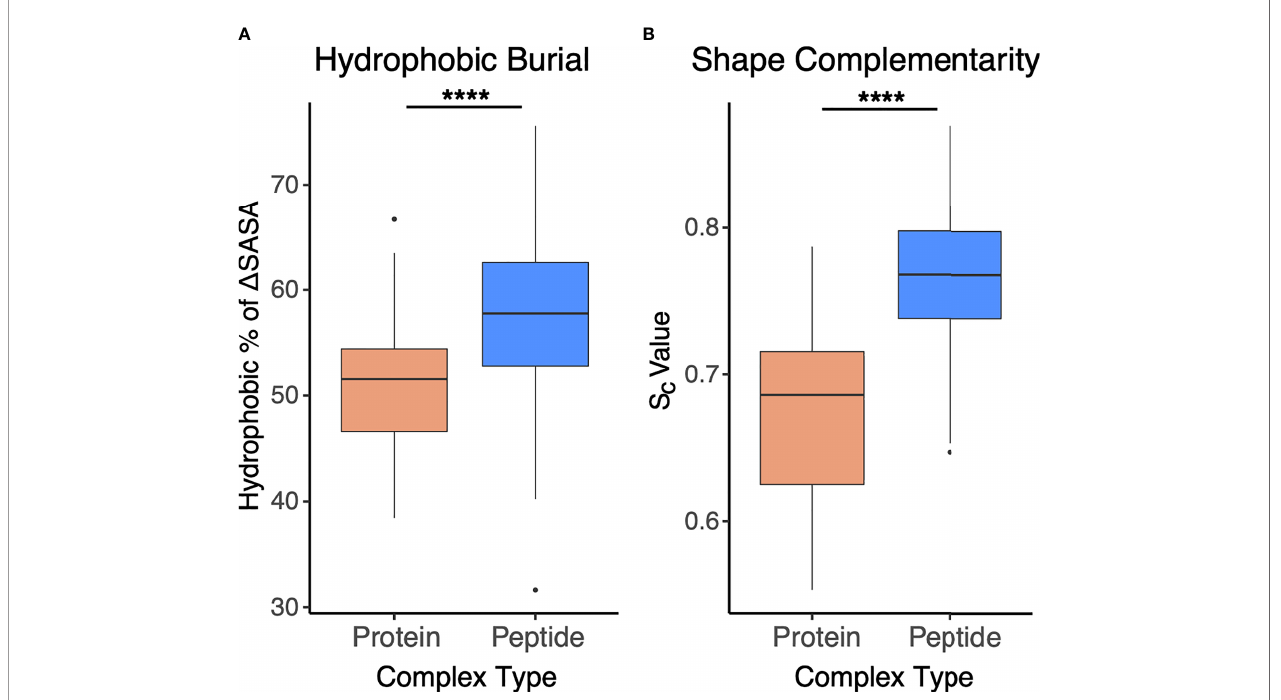
FIGURE 6 | Interface hydrophobicity and shape complementarity of antibody-peptide versus antibody-protein complexes. (A) Percent of hydrophobic buried interface surface area ( D SASA), calculated by Rosetta and (B) Shape complementarity values (Sc (38), calculated by Rosetta) from antibody-protein (N = 54) and antibody-peptide (N = 188) interface structures are represented. Statistical signi fi cance between sets of values are from Wilcoxon rank sum test (****: p ≤